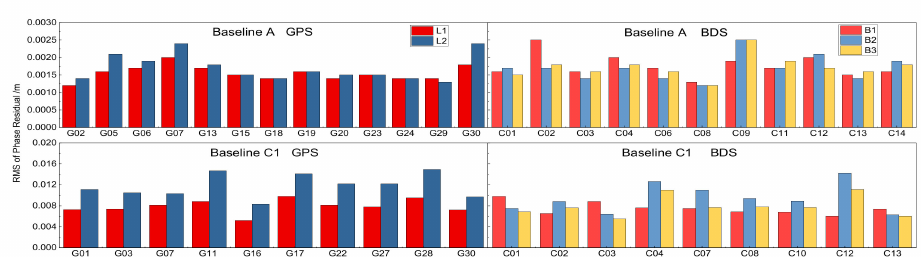
Figure 1. RMS of the posterior phase residuals for each individual satellite and frequencies of the float solutions of the short Baseline A ( top ) and C1 ( bottom ) processed in static